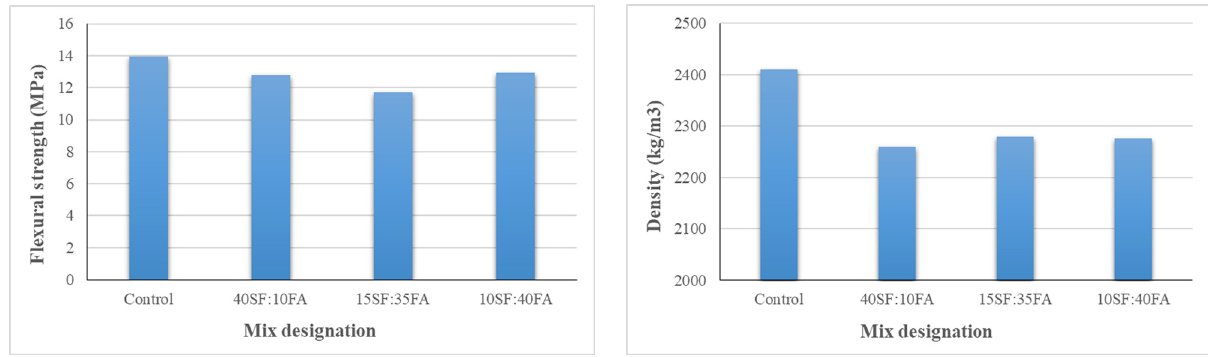
Figure 3: The fl exural strength results of RPC mixes. Figure 4: The bulk density results of